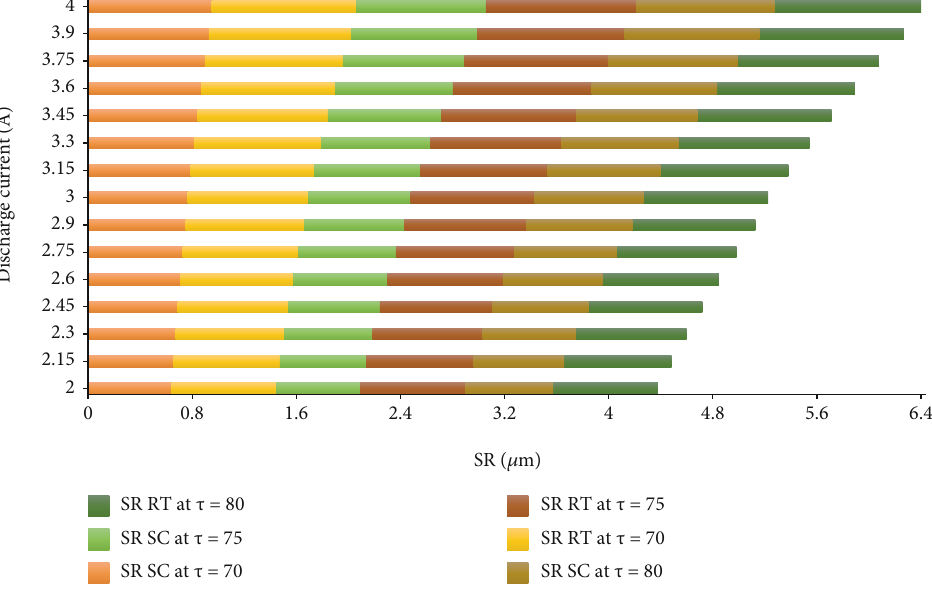
= 50microseconds on